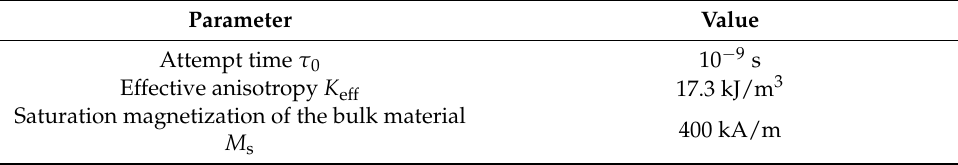
Table 2. Values of parameters (for spatial quantities) used in the simulation.